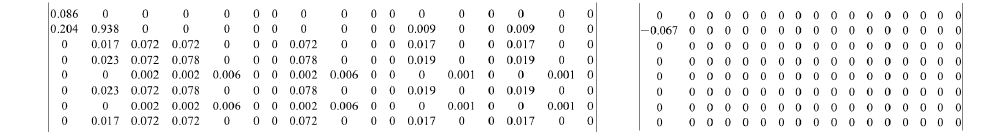
Figure A.1. The left matrix shows the node-edge similarity scores, whereas the right matrix holds the motion constraints scores.